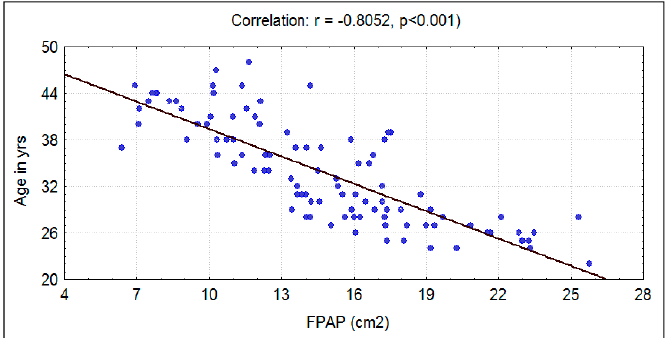
Figure 2. Correlation between age in years with fungiform papillae count (FPAP) (per cm 2 ) in nonsmokers. Table 1. Correlation between fungiform papillae counts with age, smoking, and body mass index (BMI).